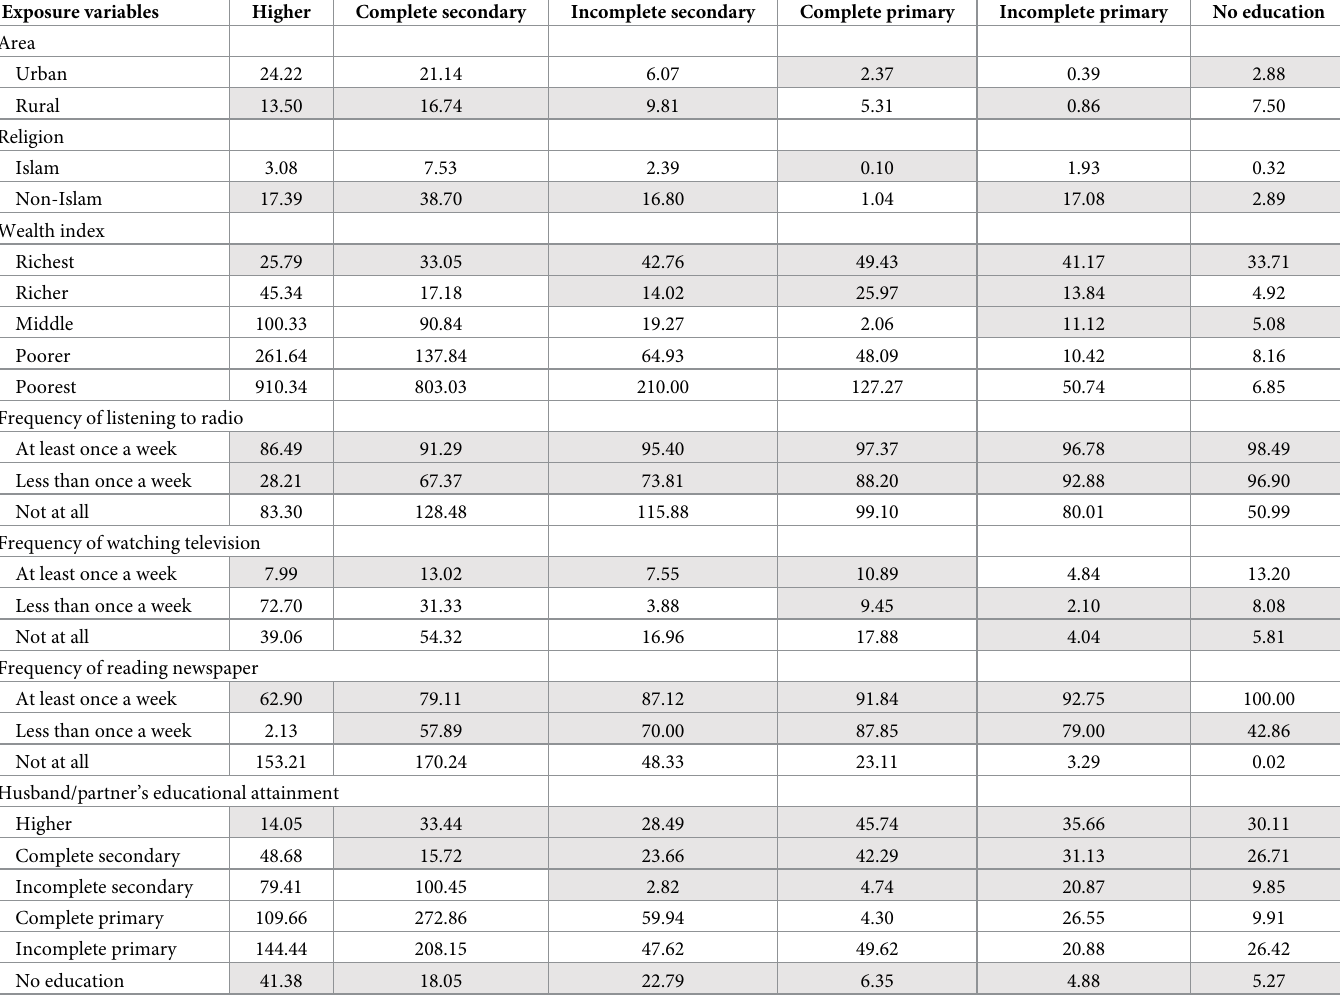
Table 1. Change in proportion 1 of different exposures among different education level groups between 2004 and